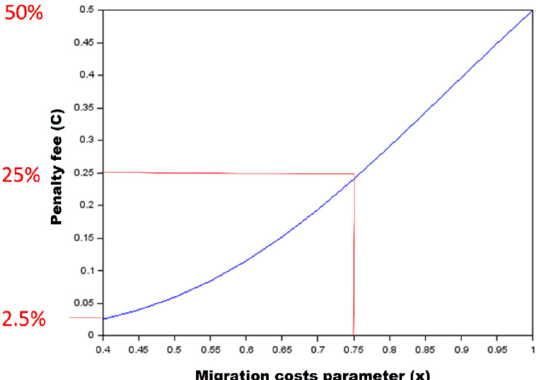
Figure 2. The dependence of migration penalty fee on migration costs parameter under nonlinearity parameter h = 4.